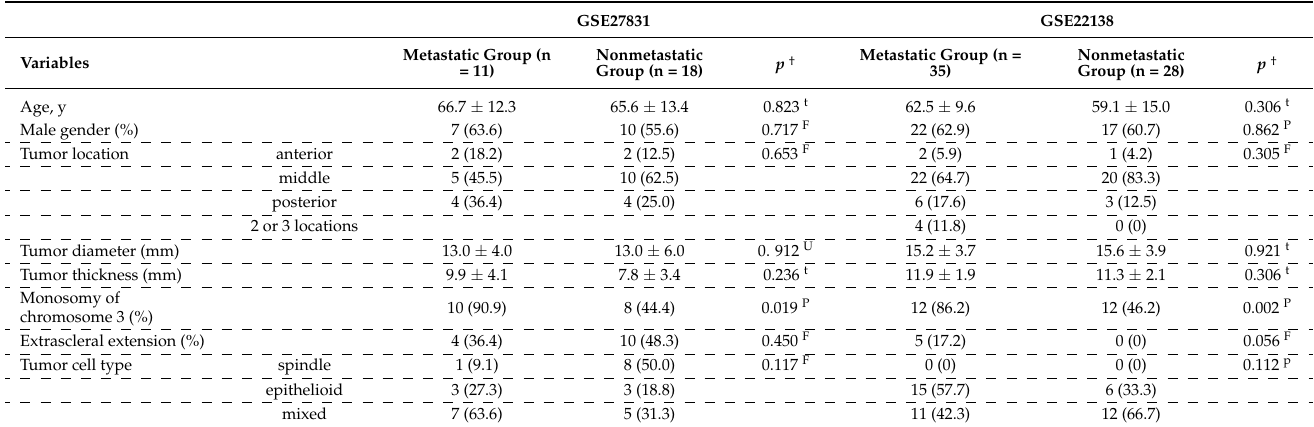
Table 1. Baseline characteristics of subjects included in the analysis